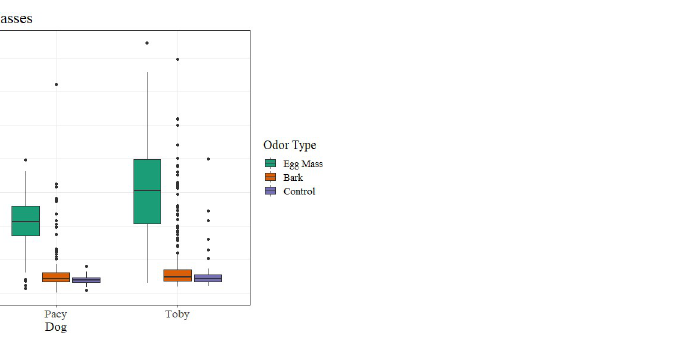
Fig 10. Duration that each dog spent at each port by what was in each port (either egg masses, bark, or controls) for live spotted lanternfly egg masses during training.